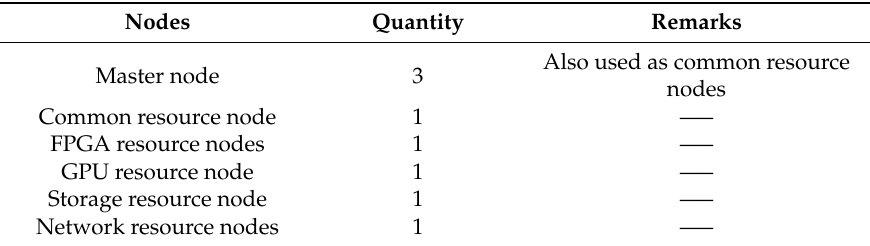
Table 1. Resources in the test platform.